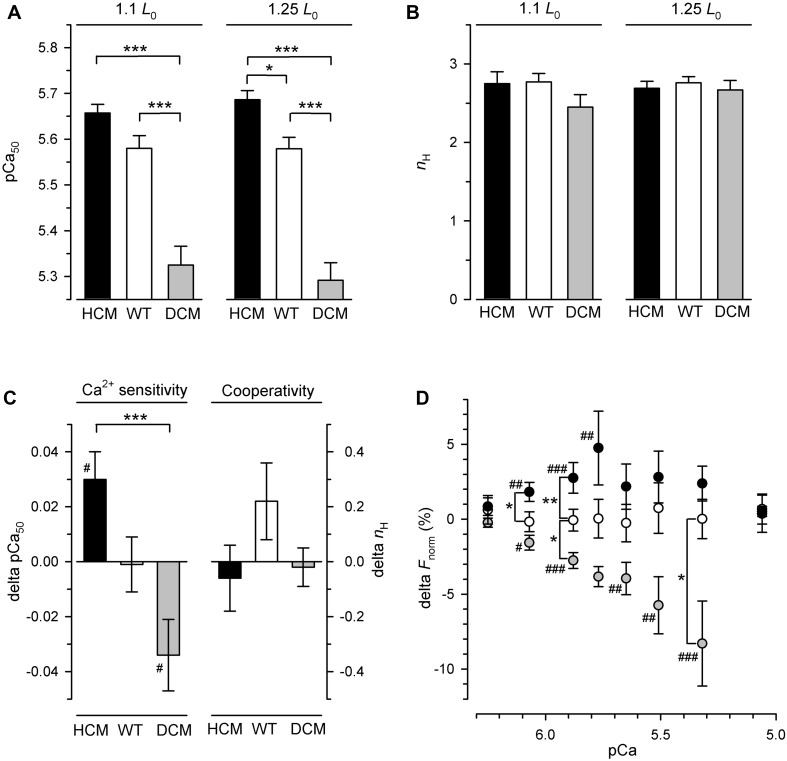
Length-dependent parameters and parameter changes of calcium-dependent force generation of hcTn-exchanged skinned fibers. HCM: fibers containing hcTnTR130C (black circles and bars), WT: fibers containing hcTnTWT (white circles and bars), DCM: fibers containing hcTnTΔK210 (gray circles and bars). (A) Calcium sensitivity is expressed by the pCa50 required for half-maximum increase of calcium-dependent force generation. (B) Cooperativity of calcium-dependent force generation is expressed by the Hill coefficient nH of force-pCa relations. (C) Change of pCa50 and Hill coefficient nH induced by lengthening the fiber from 1.1 L0 to 1.25 L0. (D) Change of normalized force at the respective pCa induced by lengthening the fiber from 1.1 L0 to 1.25 L0. Change (delta) of parameters in (C,D) are calculated by subtracting for each fiber the parameter value at 1.1 L0 from the parameter value at 1.25 L0. Significant change of parameter (delta different from zero) is indicated by #P < 0.05, ##P < 0.01, ###(P < 0.001). Asterisks indicate significant differences *P < 0.05, **P < 0.01, ***P < 0.001 between the hcTnT-types in Tukey’s multiple comparison post-tests. For sake of clarity, only the P-values for comparisons between mutants and wild type but not the ones comparing the two mutants were plotted in the subfigure (D) (for complete list of P-values see Table 2).